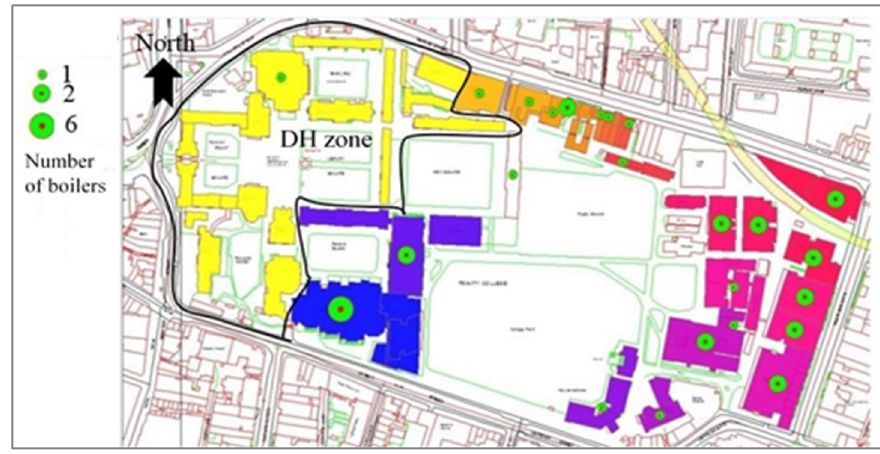
Figure 2. The current heating systems of TCD.